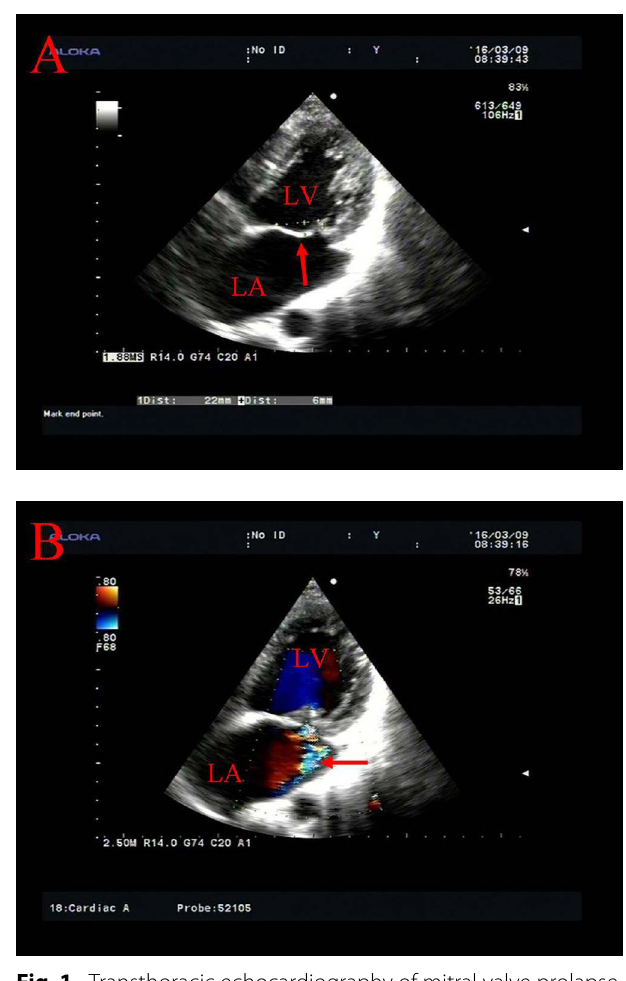
(A) Prolapse of the anterior mitral leaflet with movement of the coaptation behind the annular plane (arrow); (B) Mitral insufficiency with a regurgitant flow along the posterior wall of the left atrium (arrow). LA=left atrium; LV=left